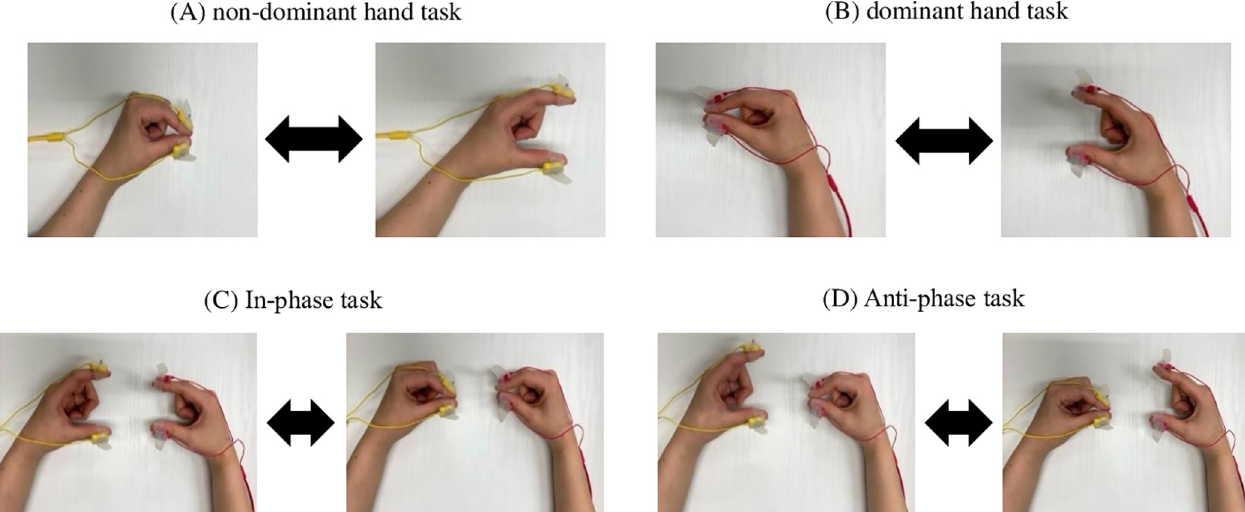
Fig 2. Finger-tapping movements. (A) A tapping action with the left thumb and index finger is performed. (B) A tapping action with the right thumb and index finger is performed. (C) Tapping with the in-phase task is performed. (D) Tapping with the anti-phase task is performed. The distance between the thumb and index finger is kept between 3 and 4 cm, and movement was performed as fast as possible for 15 s.